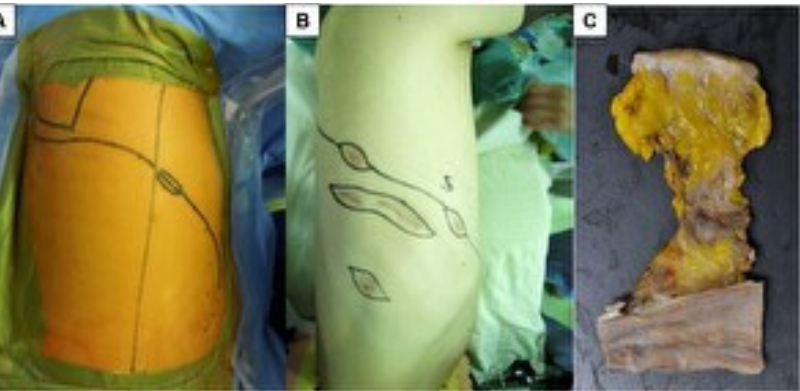
Figure 1. En bloc resection was attempted as curative-intent surgery. When pleural biopsy was performed via a single port, a posterolateral incision, including the biopsy site, was made ( A ). When pleural biopsy was performed via multiple ports or incisions, a posterolateral incision and an isolated incision-like island were made ( B ). Isolated removed biopsy site in which was removed including skin to parietal pleura ( C ).